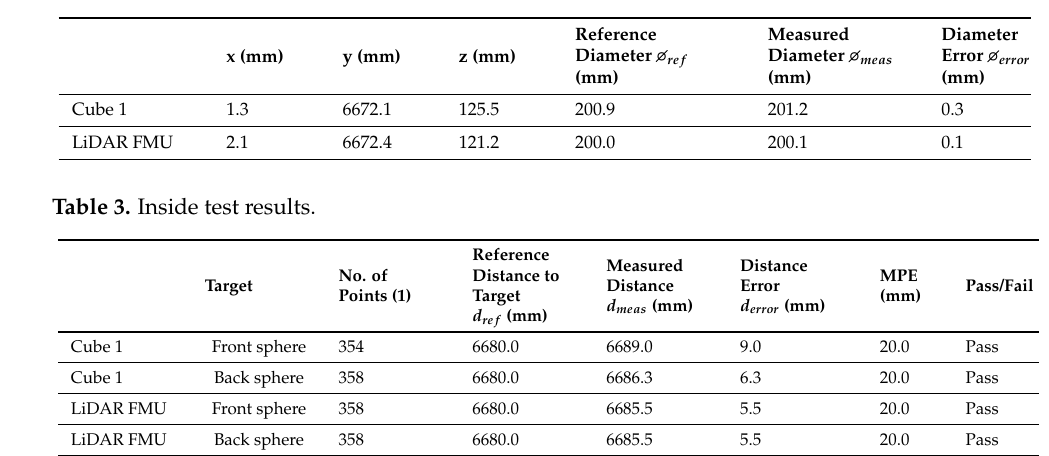
Table 2. Diameter ◦ and the cartesian coordinates of derived points of simulated and real sphere targets are obtained by LSSF.